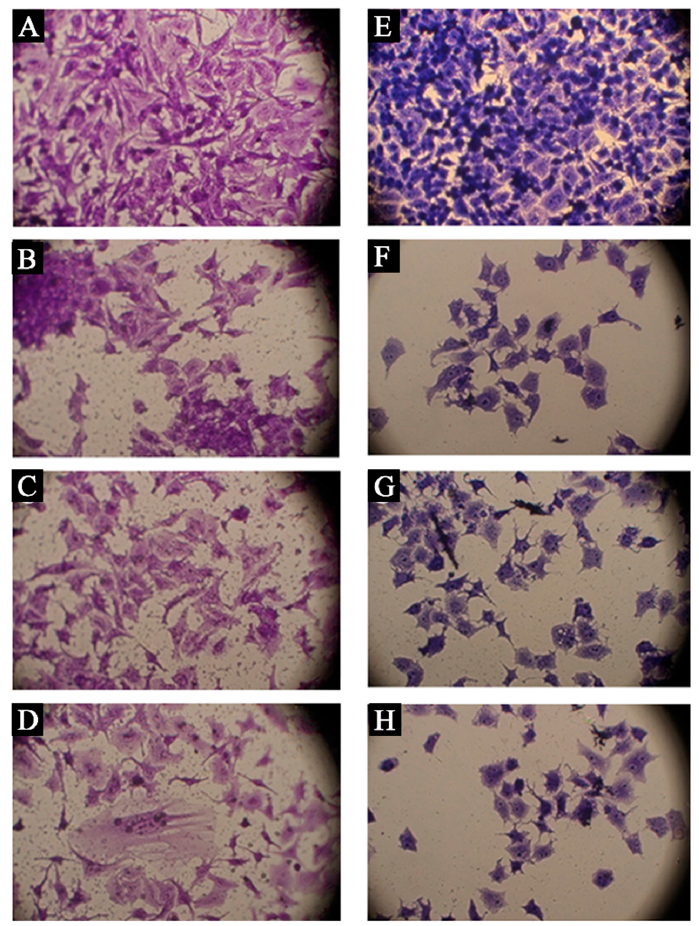
Figure 9. Morphological changes of cancer cells after treatment with the prepared NPs. ( A ) Non- treated AMJ13 cells, ( B ) Au NP-treated AMJ13 cells, ( C ) ZnO NP-treated AMJ13 cells, ( D ) Au/ZnO NC-treated AMJ13 cells, ( E ) non-treated SK-GT4 cells, ( F ) Au NP-treated SK-GT4 cells, ( G ) ZnO NP- treated SK-GT4 cells, and ( H ) Au/ZnO NC-treated SK-GT4 cells.